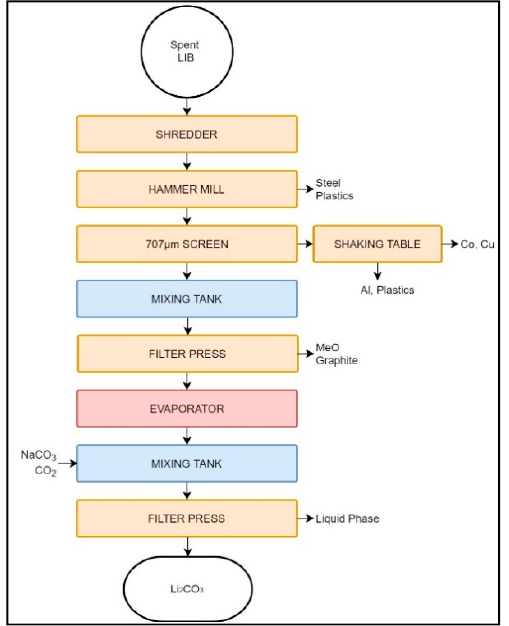
Figure 2. Schematic representation of the Retriev LIB recycling process.